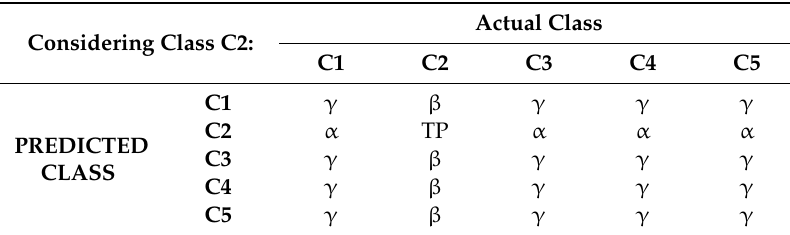
Table 2. Representation of the confusion